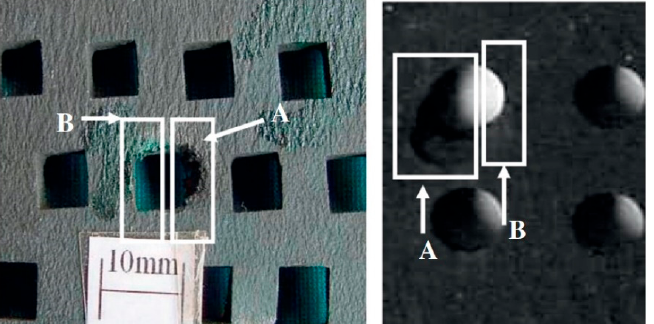
Figure 14. 6 mm square and circular perforation damage: area A is the deformed and area B is the non-deformed region of a similar morphology [47]. Reprinted with permission from Elsevier: Mater.